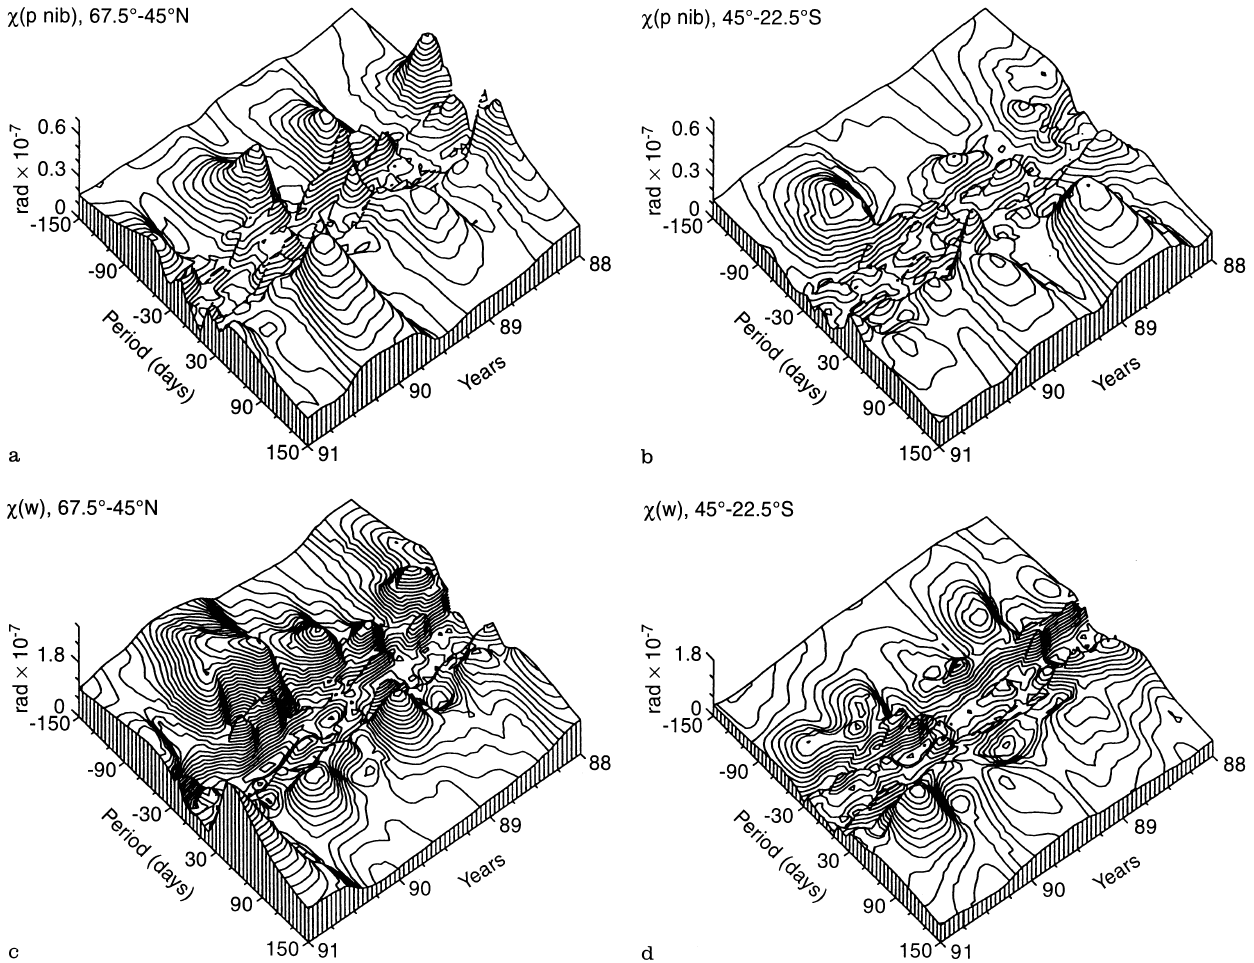
Fig. 4 a-d. Time-variable FT BPF amplitude spectra of the complex-valued a, b pressure and c, d wind terms of the (cid:118) component of the zonal EAAM (JMA) excitation functions; + denotes the prograde oscillations, ) denotes the retrograde